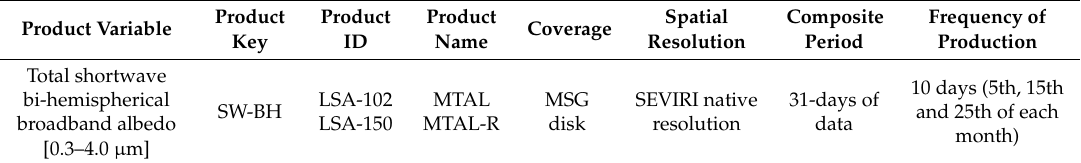
Table 1. Satellite Application Facility for Land Surface Analysis (LSA SAF) Meteosat Second Generation